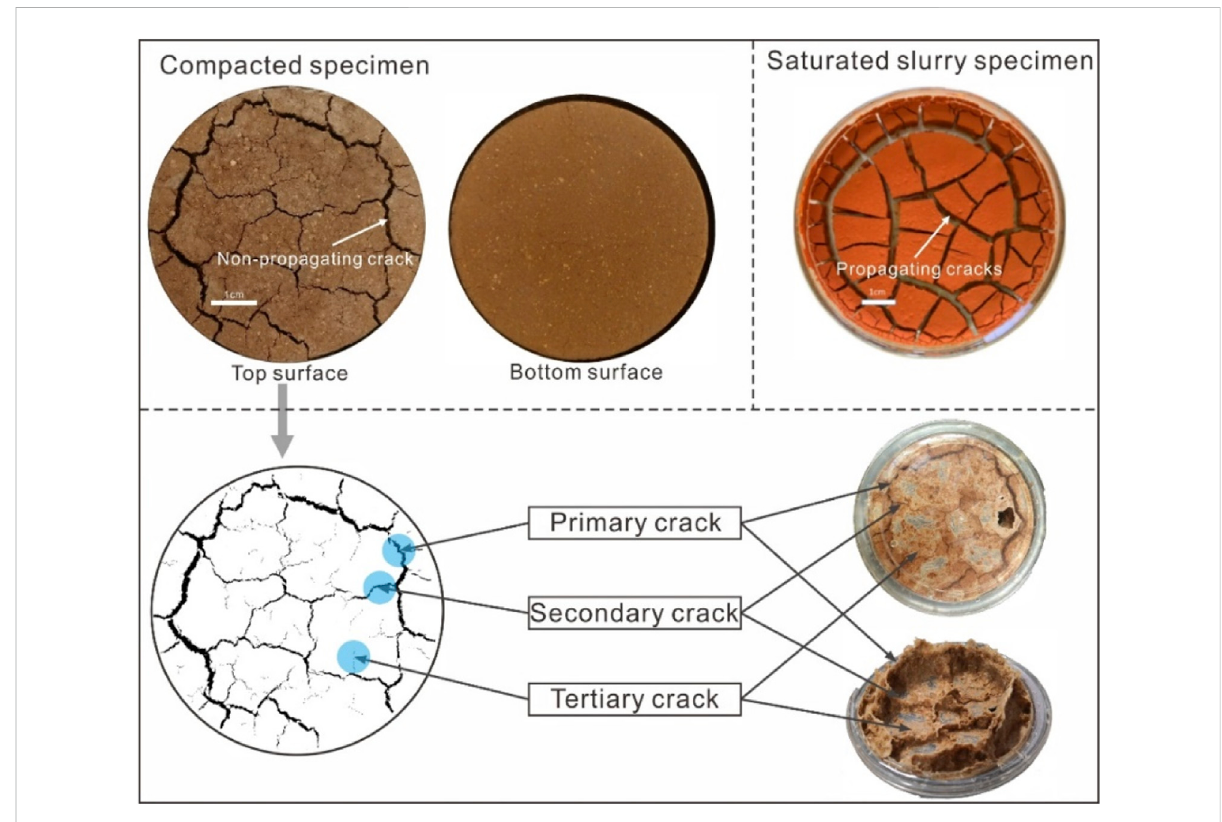
FIGURE 12 Difference of desiccation cracks between saturated slurry and compacted specimen. Propagating cracks in slurry specimen, and non- propagating cracks in compacted